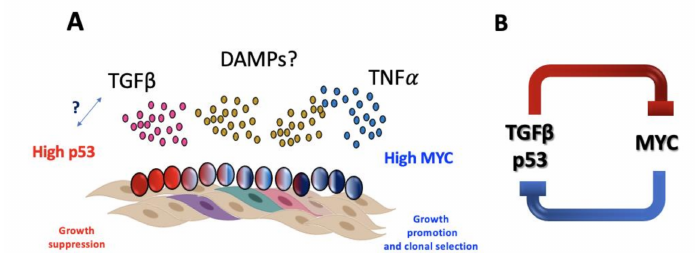
Figure 9. HSPCs in di ff erent functional states co-exist in the FA bone marrow and respond di ff erentially to microenvironmental stimuli. ( A ) Overexpression of di ff erent pro-inflammatory cytokines has been described in FA and can have opposite e ff ects on responsive HSPCs. On the one hand, TGF β inhibits the proliferation of FA HSPCs. It is currently unknown if TGF β and p53 are functionally linked in FA HSPCs, however both proteins suppress proliferation and have increased levels in the FA bone